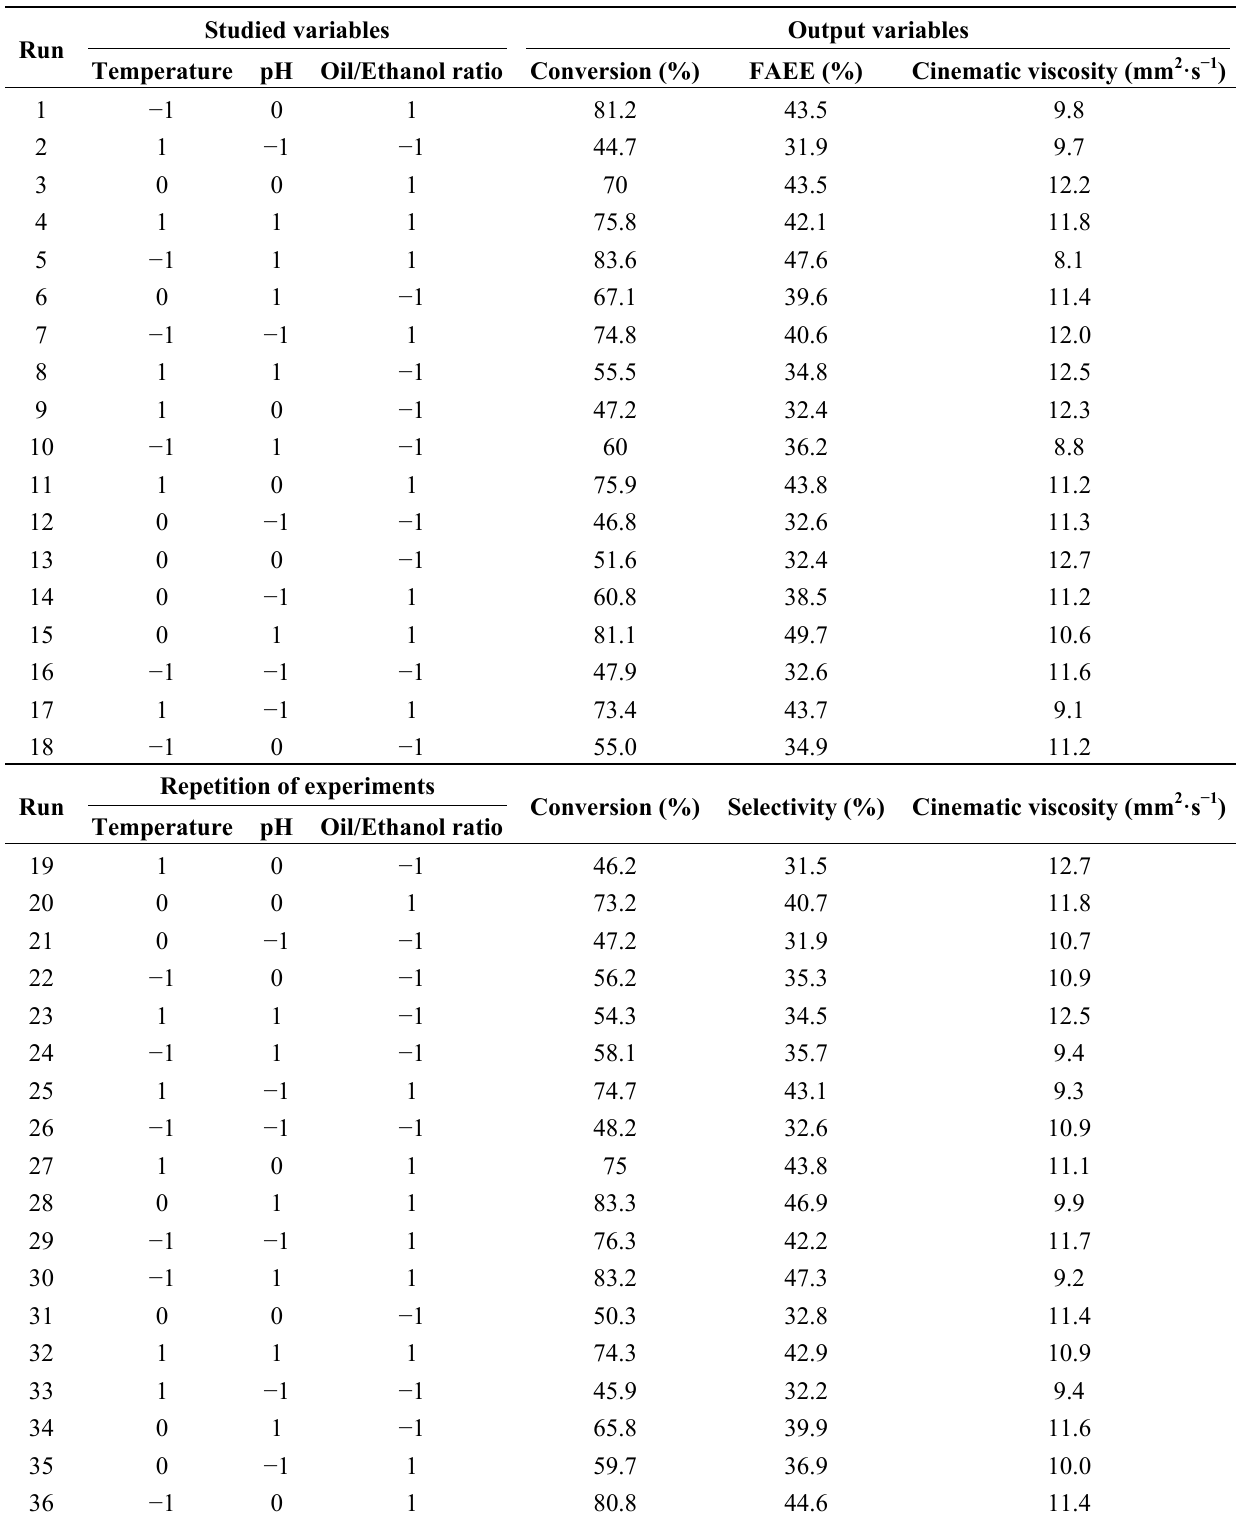
Table 2. Experiments matrix of factorial design and the response obtained for conversion, selectivity and